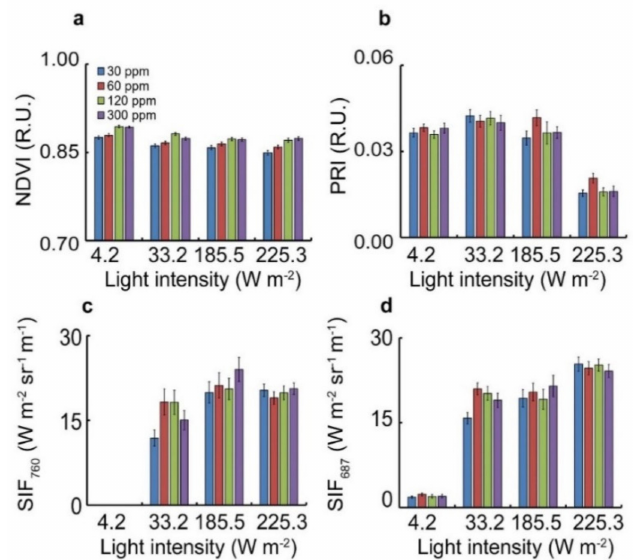
Figure 3. Vegetation indices and sun-induced fluorescence (SIF) calculated for L. sativa , along a fertilizer gradient, two weeks after planting. ( a – d ) represent the normalized di ff erential vegetation index (NDVI), photochemical reflectance index (PRI), SIF 760 and SIF 687 , respectively. The four colored bars represent the fertilizer gradient, where blue, red, green and purple are 30, 60, 120 and 300 ppm of the total nitrogen, respectively. Error bars represent standard error of the mean at n = 30 per fertilization